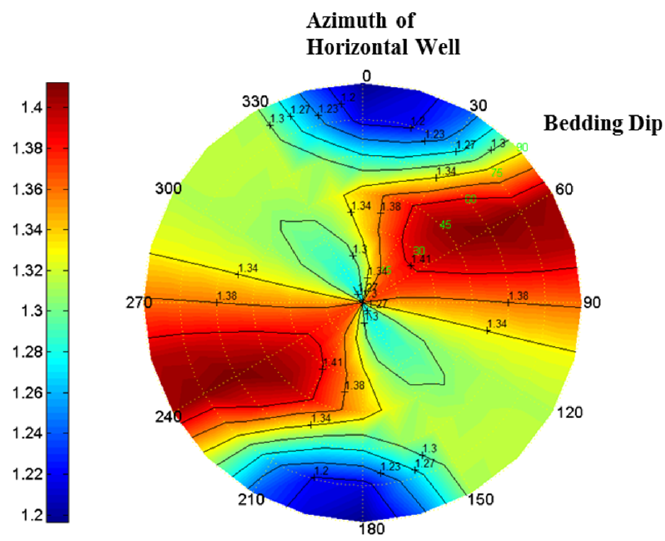
Figure 11. Collapse pressure of horizontal borehole for different well azimuths and dip angles of bedding planes (dip direction of bedding plane is at 15°; direction of the minimum horizontal stress is at 60°).